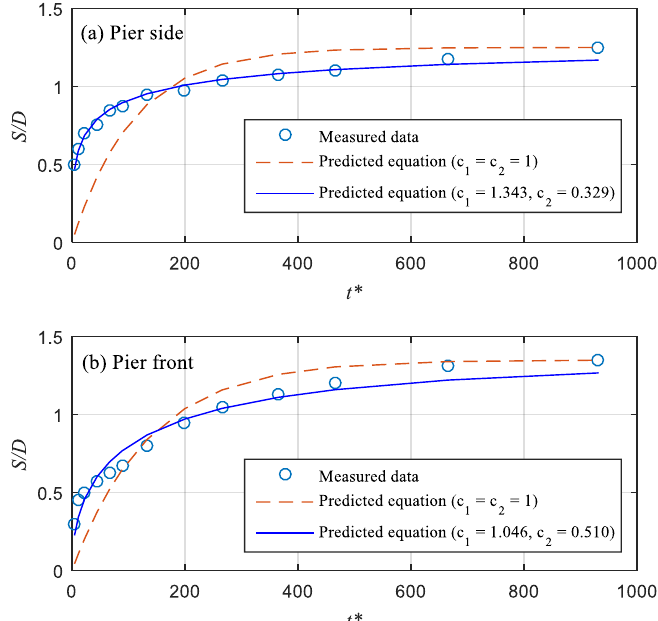
Figure 6. Comparison between the predicted and measured temporal development of scour depth at the ( a ) side and ( b ) front face of the pier.